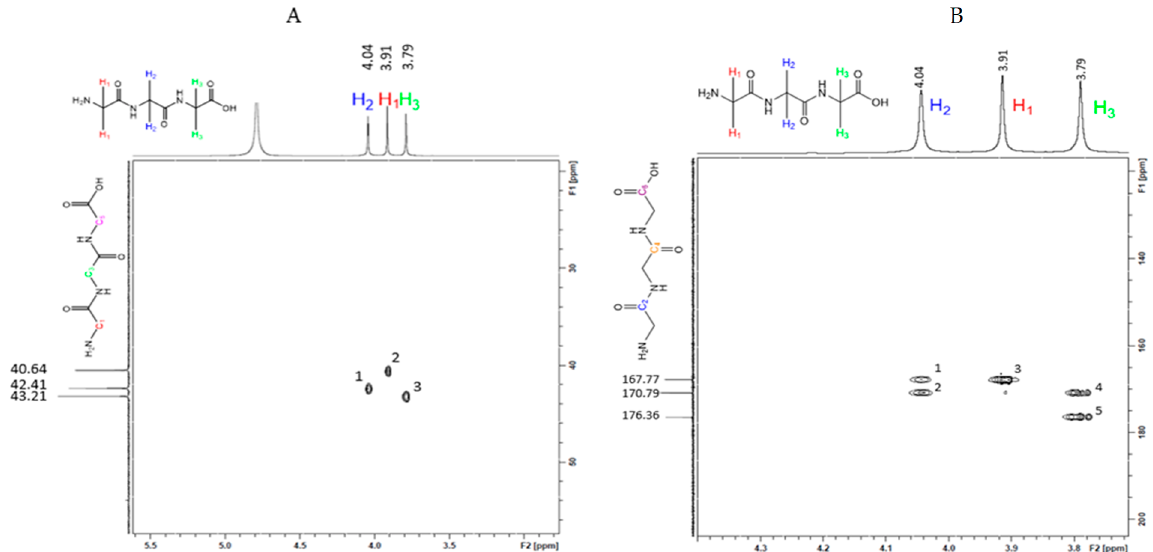
Figure 4. 2D HSQC of HG 3 ( A ) showing a single coherence point between each proton and its corresponding carbon (1:1:1) and the 2D HMBC of HG 3 ( B ) showing two correlation points between H 2 and two carbons (C 2 –167.8 ppm; C 4 –170.8 ppm) and H 3 and two carbons (C 4 –170.8 ppm; C 6 –176.4 ppm), as well as one correlation point between H 1 and one carbon (2:1:2). Full spectra available in Supplemental Figure S10.